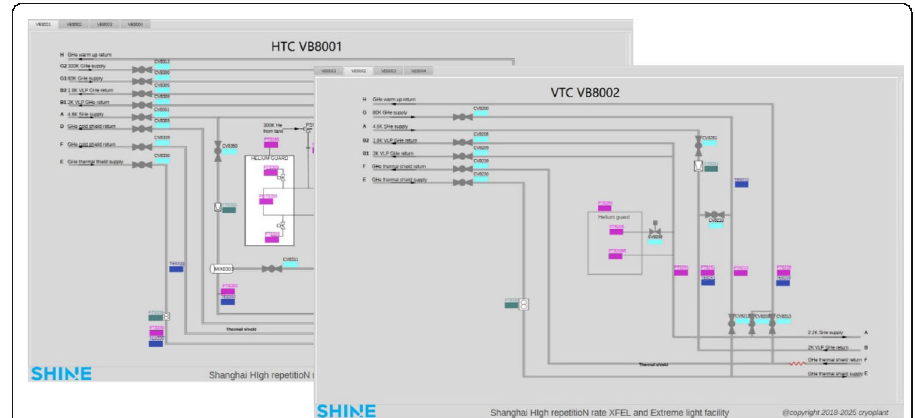
Fig. 5 Distribution valve box ’ s GUIs by